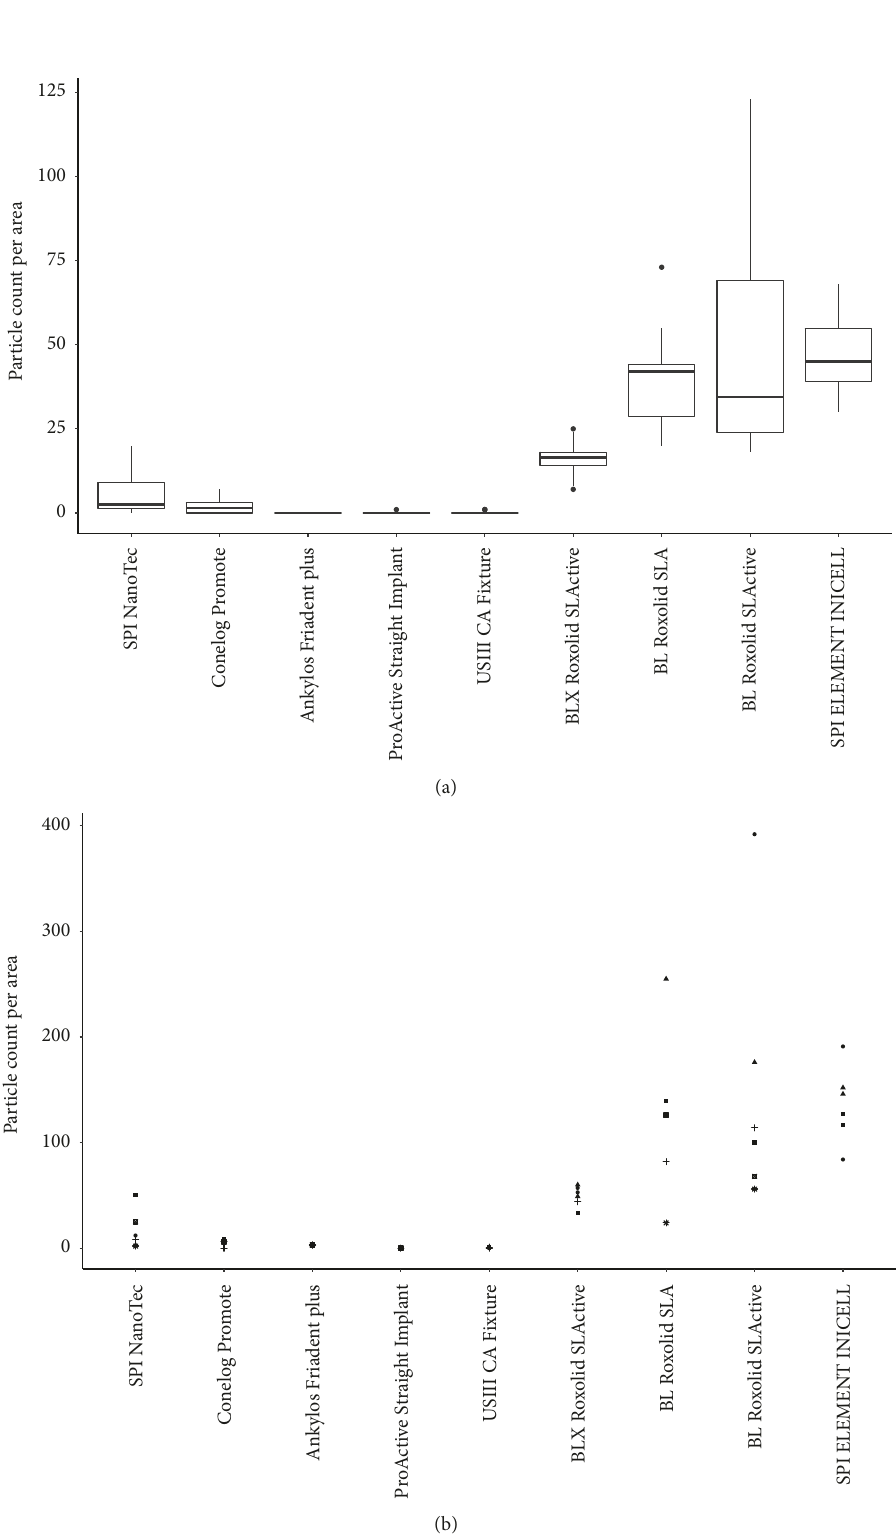
Figure 4: Particle count variation in 9 implant systems: (a) box plot of surface particle counts in 9 implant systems; (b) variations in surface particle counts; different markers indicate implants of different